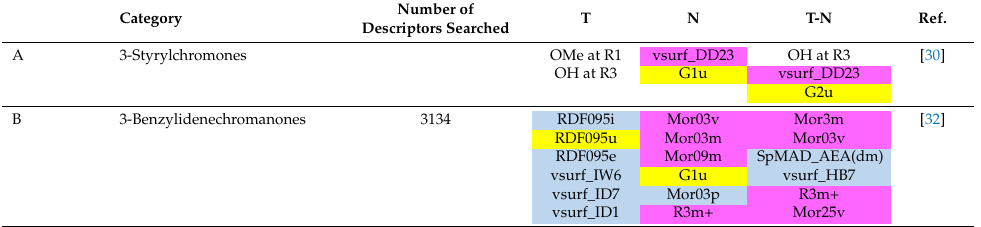
Table 2. Top six chemical descriptors that showed the highest correlation to cytotoxicity to tumor cells ( T ) or normal cells ( N ) or tumor-specificity ( T–N ). Descriptors are explained in the footnote. Pink, molecular size; yellow, 3D shape; orange, topological shape; blue, electrostatic; green, lipophilicity. Category Number of Descriptors